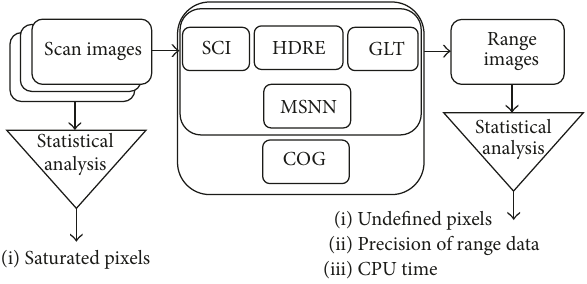
Figure 9: Generalized processing flow graph of main